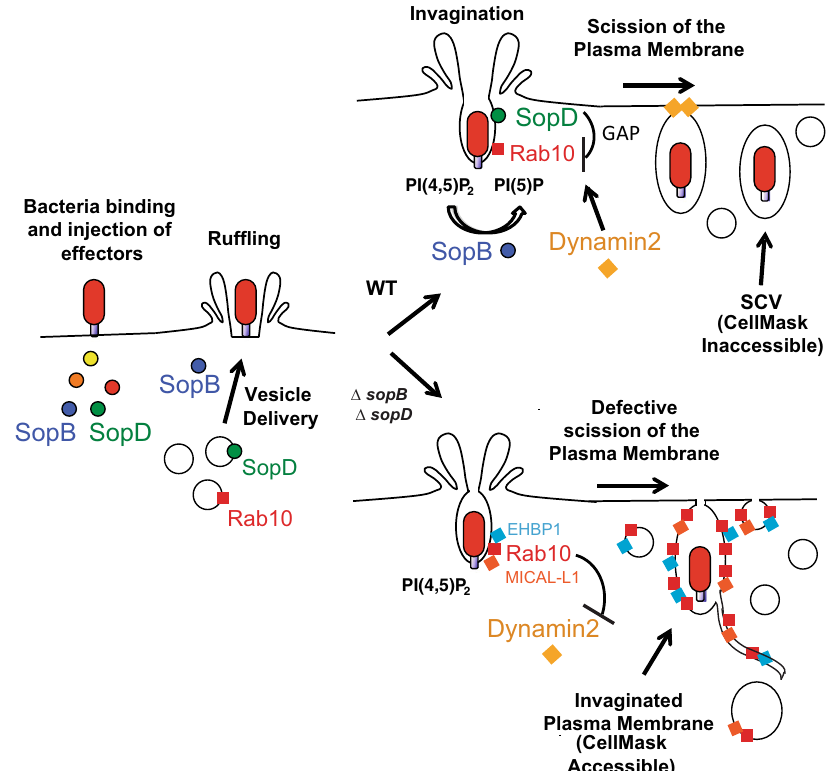
Fig. 7 The Salmonella effector SopD targets Rab10 to promote plasma membrane scission during invasion. Model depicting the results of this study.